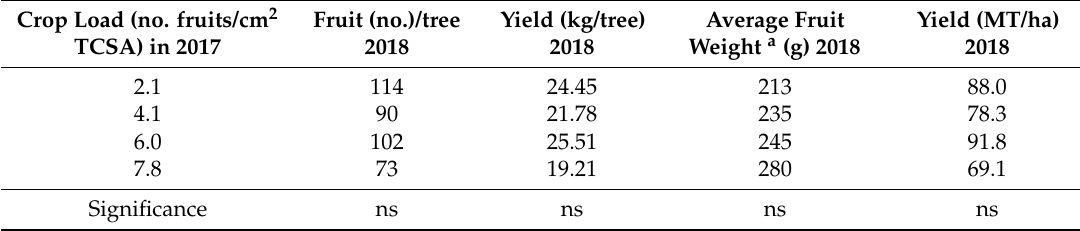
Table 2. The effects of induced crop load in 2017 on the number of apples/tree, yield (kg/tree), average fruit weight (g), and production (MT/ha) for “WA38” apples grown in Washington State, Wenatchee area in 2018.